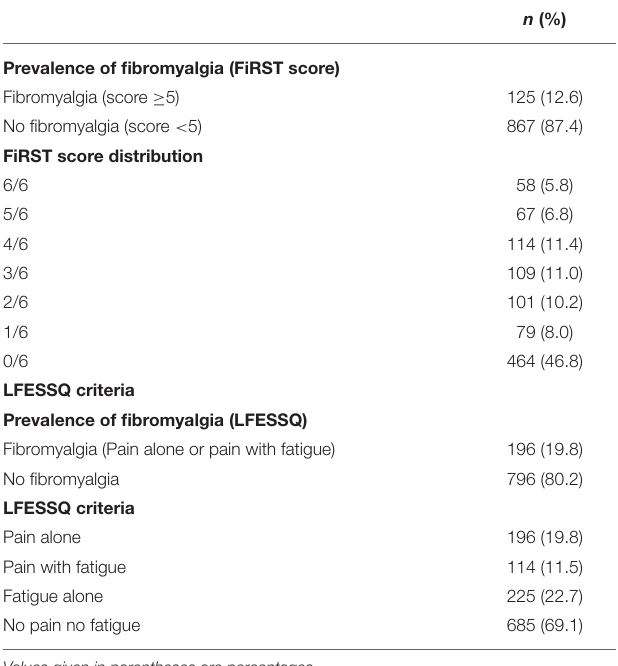
TABLE 1 | Prevalence of fibromyalgia during an outbreak ( n = 992). TABLE 2 | Relationship of fibromyalgia with demographic characteristics